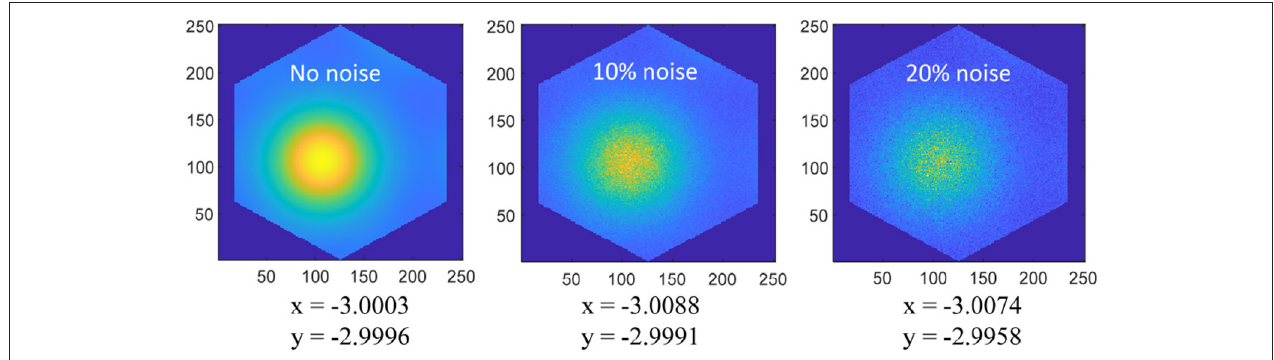
FIGURE 18 | Coordinate positions ( − 3, − 3) are coded on the 250 × 250 grid cell neural plate, and a single period of hexagonal lattice is intercepted according to the size of the grid period. Add 0, 10 % , 20 % amplitude Gaussian noise to the grid activation value, and then decode the space coordinates as shown in the figure, the noise has very little interference on the position